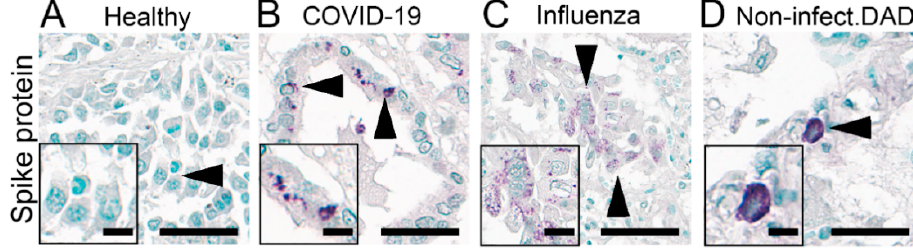
Figure 8. Immunohistochemical staining of SARS spike glycoprotein. IHC staining of SARS spike glycoprotein (#Ab272420) in the lung autopsies collected from patients without any respiratory disease ( A , Healthy; insert: respiratory epithelial cells) and patients infected with COVID-19 ( B , COVID-19; insert: respiratory epithelial cells), influenza ( C , Influenza; insert: respiratory epithelial cells) and non-infectious diffuse alveolar damage ( D , Non-infect.DAD; insert: cell with features of an alveolar macrophage) with apparently (false-) positive staining (arrowhead). Scale bars represent 40 and 10 µm (insert).